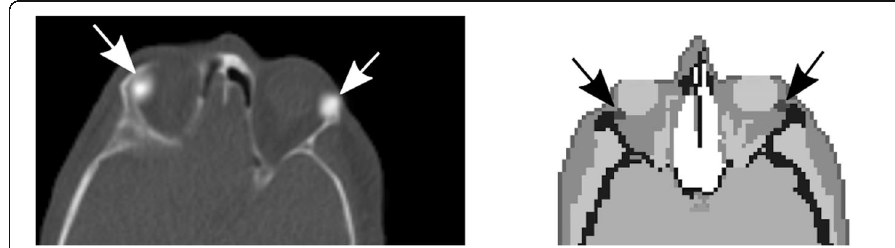
Fig. 2 Lacrimal glands. PET/CT image of the [ 68 Ga]PSMA-11 uptake in the lacrimal glands (left). One slice